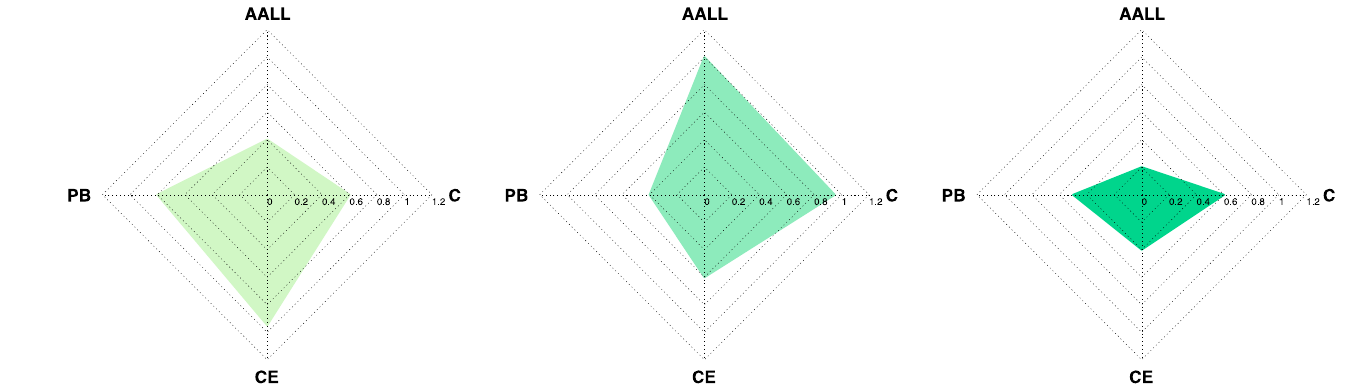
Figure 7. Normalised post-retrofit costs (C), carbon emissions (CE), payback period (PB) and average loss of life (AALL) of three hypothetical retrofitting configurations: seismic strengthening ( left ); energy efficiency refurbishment ( centre ); integrated intervention ( right ).